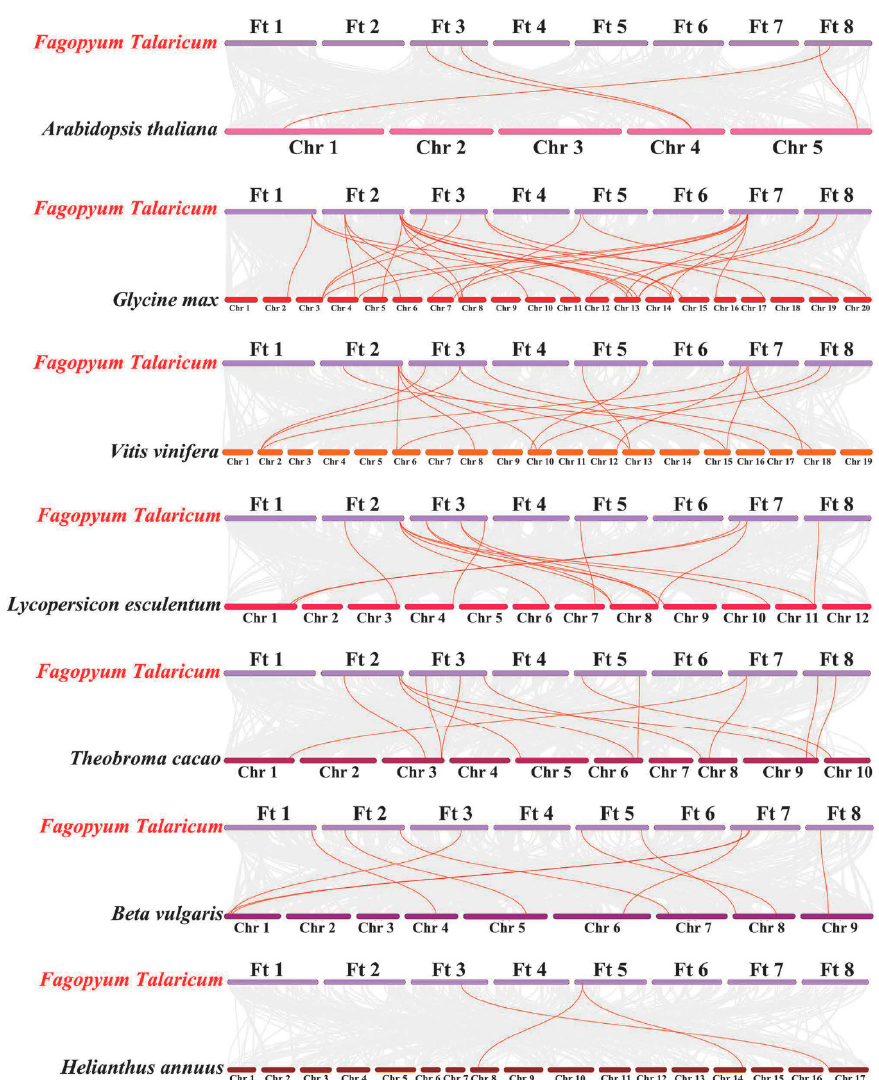
Figure 3. Synteny analysis of ARF genes between tartary buckwheat and seven representative plant species. Gray lines in the background indicate the collinear blocks within tartary buckwheat and other plant genomes, while the red lines highlight the syntenic ARF gene pairs.